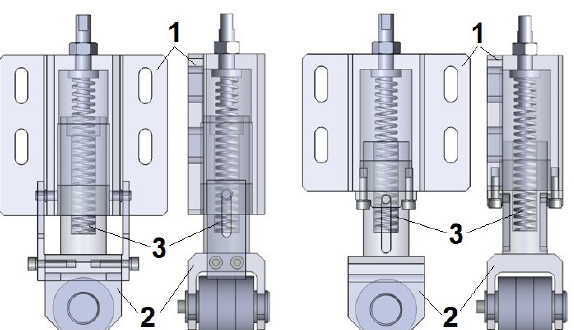
Figure 2: Pallet brake design